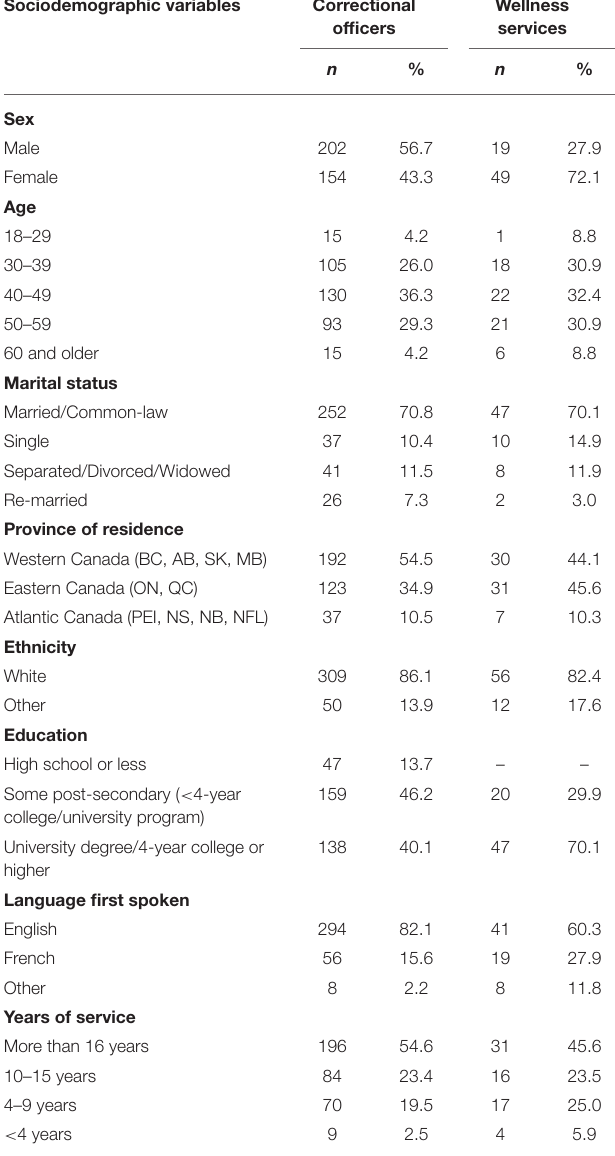
TABLE 1 | Sociodemographic variables between institutional wellness services and corrections